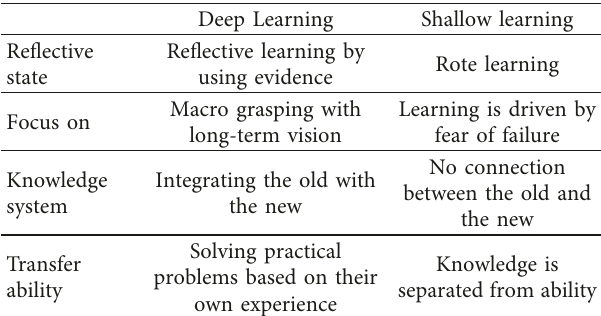
Table 1: The relationship between Deep Learning and shallow